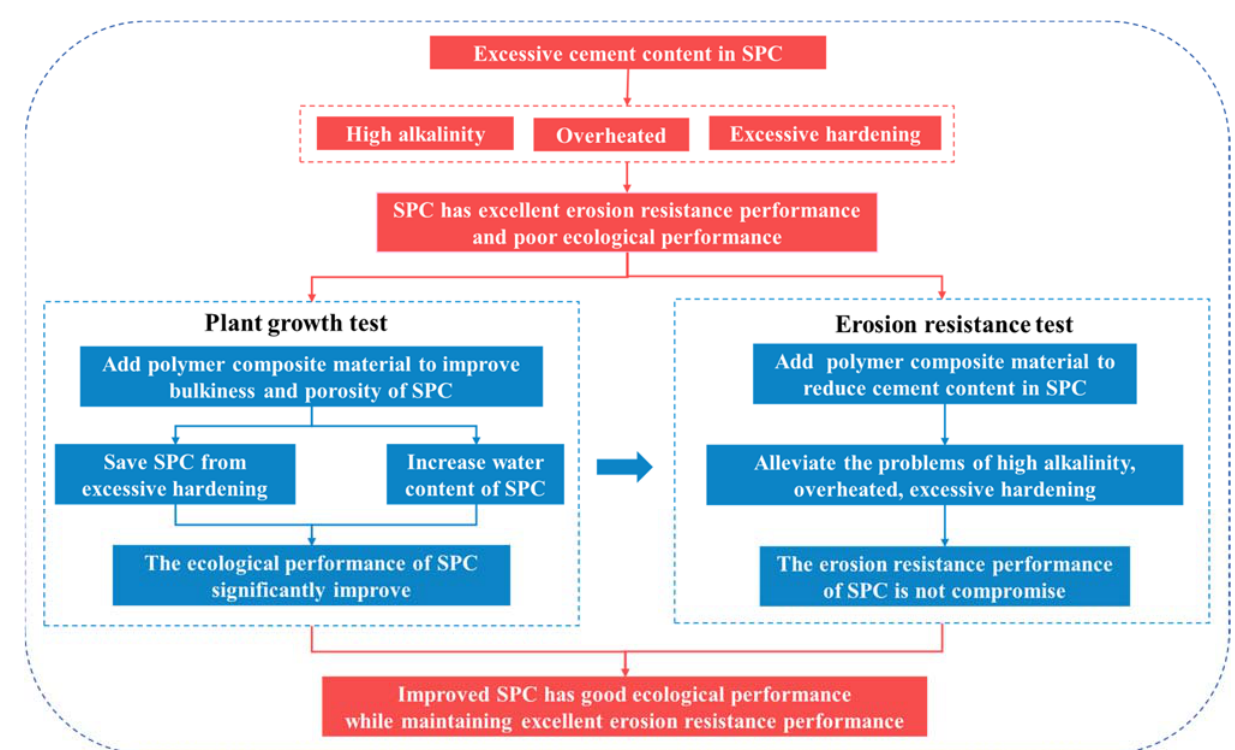
Figure 1. Experimental methodology.